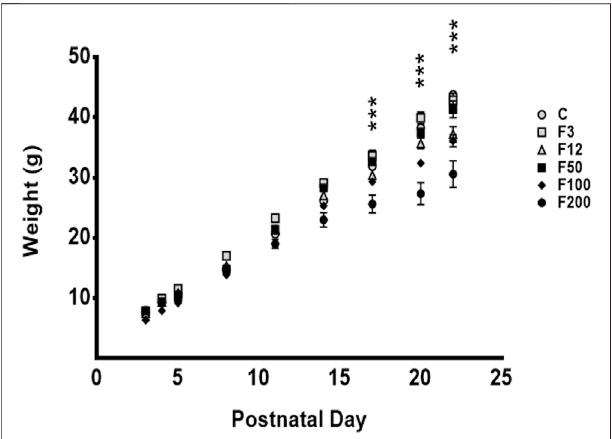
FIGURE 3 | Body weight curves of rat pups exposed to fentanyl from postnatal day 2 (P2) until weaning (P22). From P17, a lower weight was observedonlyinthegroupF200.F3:fentanyl ® (F)3 μ g/kg/h,F12:12 μ g/kg/h, F50: 50 μ g/kg/h, F100: 100 μ g/kg/h, F200: 200 μ g/kg/h. C, control rats. Body weights were reported in means ± SEM (g, n = 10 – 14 rats/group). *** p < 0.0001, F200 vs.